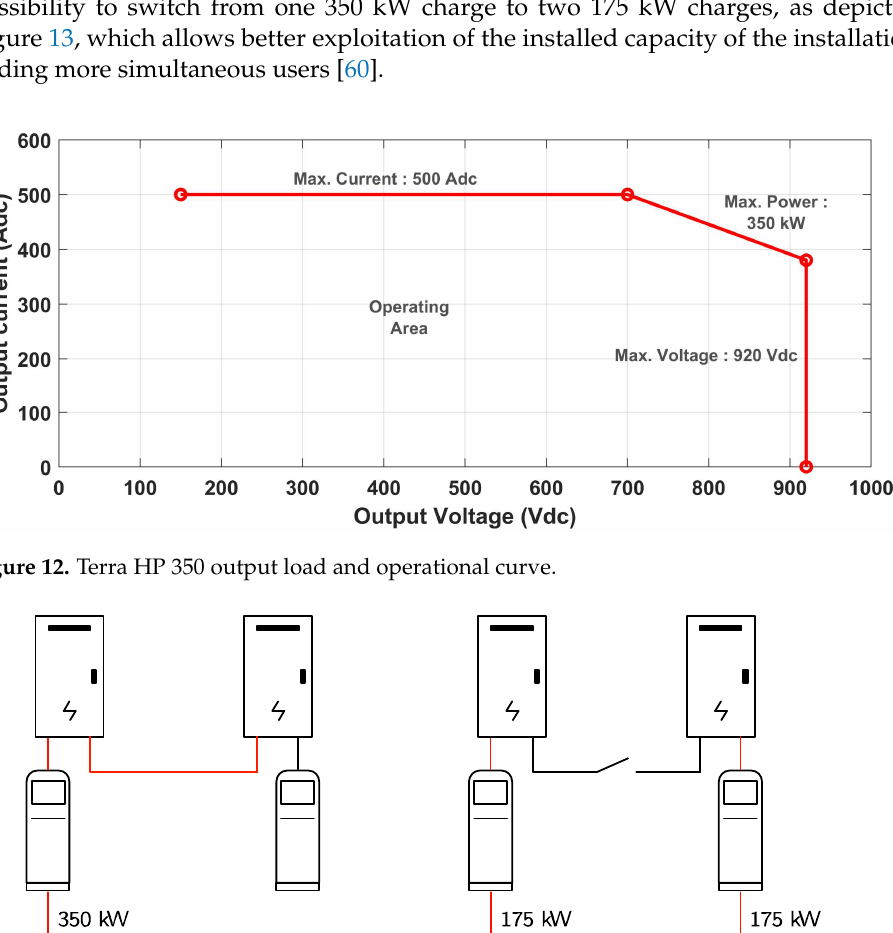
post; ( b ) shared power delivery for premium electric vehicle utilization at up to 175 kW to each